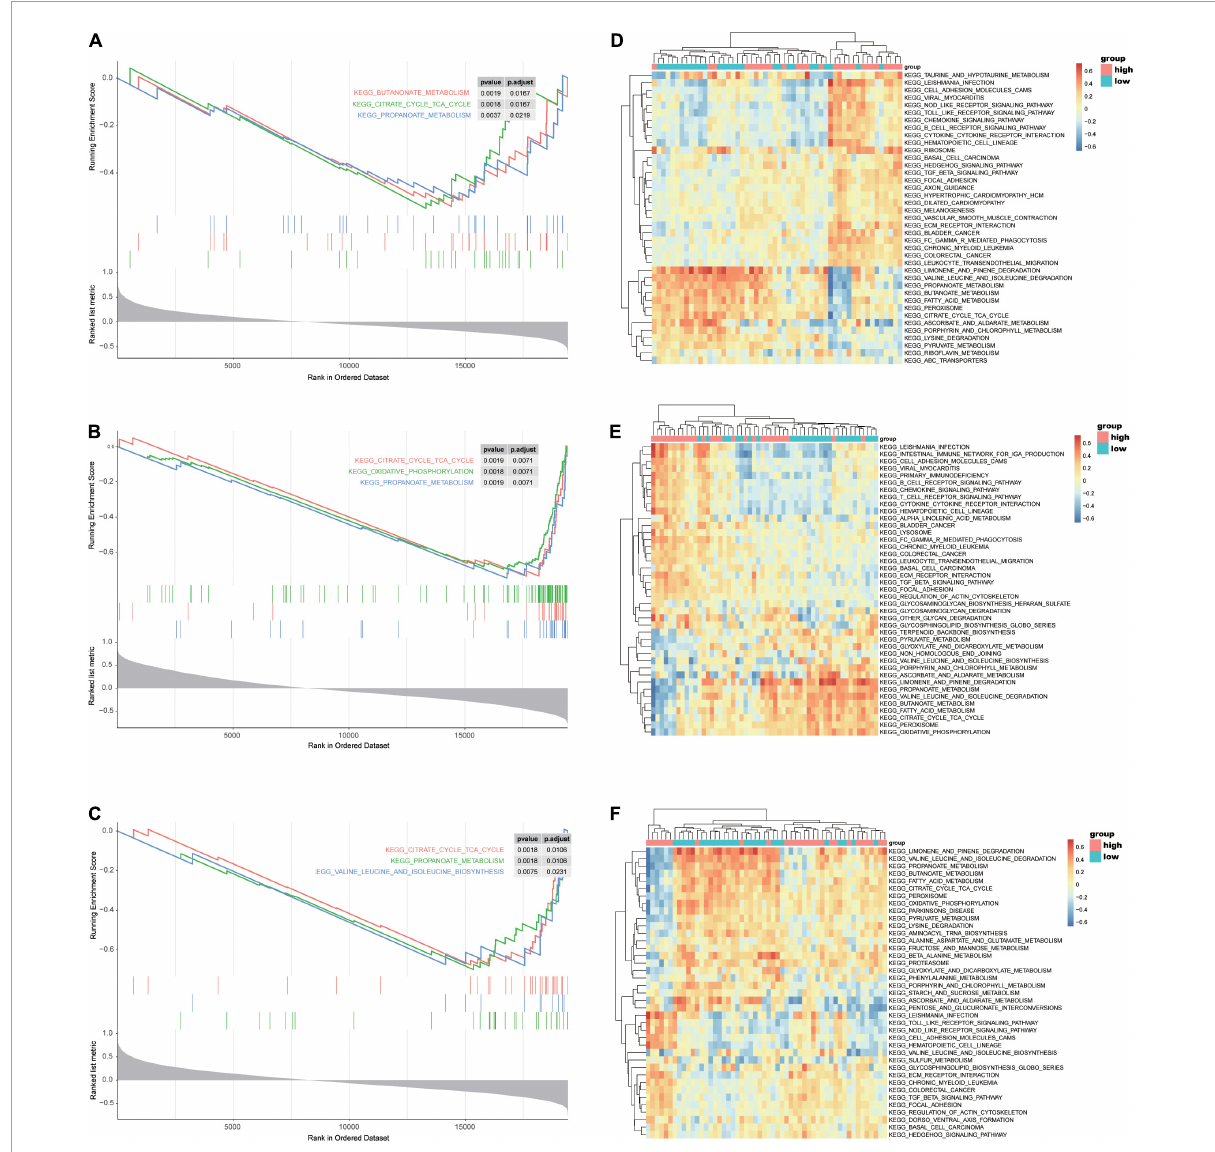
FIGURE10 GSEA and GSVA of ASPN , COL1A1 , and FMOD in the selected microarray dataset GSE57338. (A–C) GSEA-enriched pathways of DEGs related to ASPN (A) , COL1A1 (B) , or FMOD (C) expression in the GSE57338 dataset. (D–F) GSVA-derived clustering heatmaps showing the enriched pathways of DEGs related to ASPN (D) , COL1A1 (E) , or FMOD (F) expression in GSE57338 dataset. GSEA, gene set enrichment analysis; GSVA, gene set variation